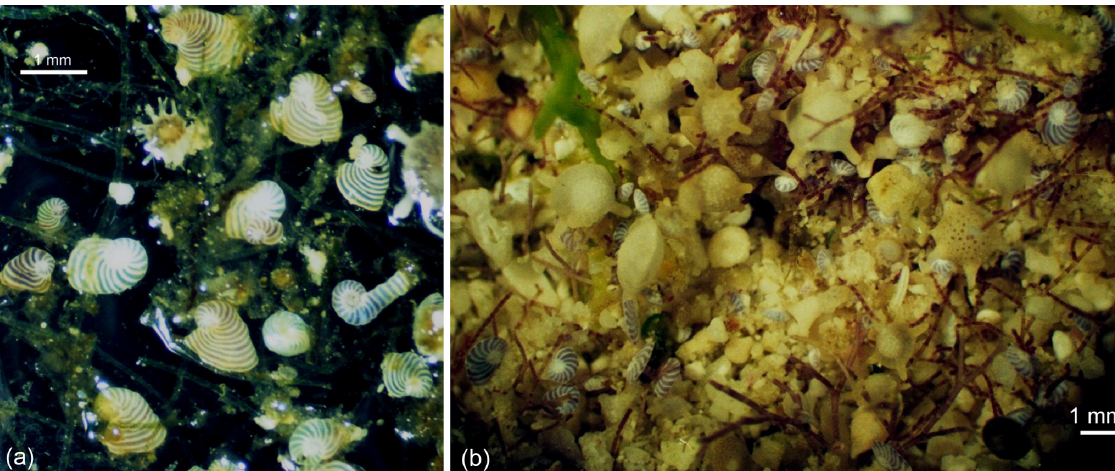
Figure 2. (a) Living peneroplids and Neorotalia calcar from algal mats on reef crests in Belau. (b) Peneroplis planatus attached to filamen- tous microalgae within sand grains from the reef crest at Sesoko Island, Japan, together with Calcarina gaudichaudii and Baculogypsina sphaerulata .